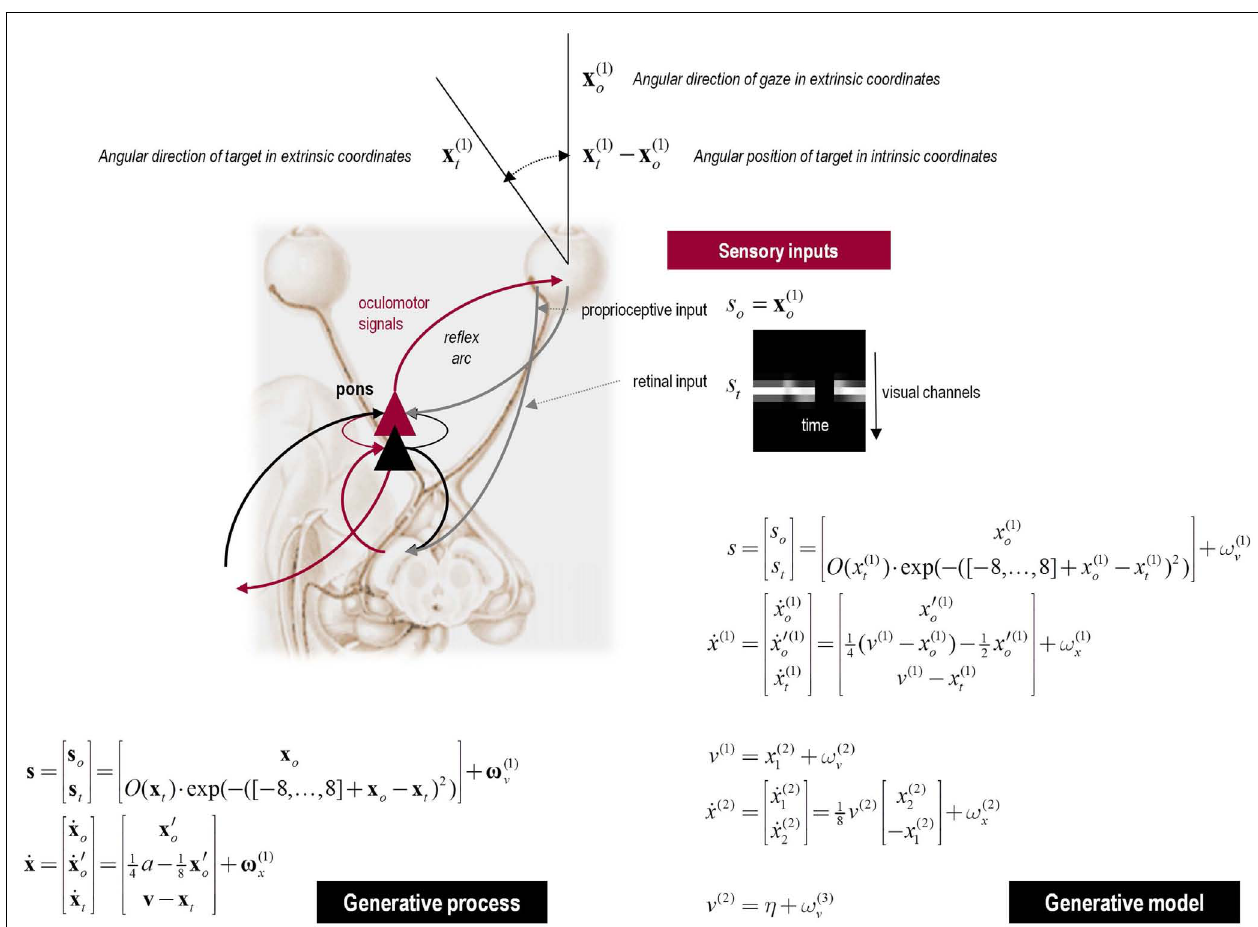
FIGURE 6 | Upper panel : this schematic summarizes the generative model for smooth pursuit eye movements .The model is based upon the prior belief that the center of gaze and target are attracted to a common (fictive) attracting point in visual space.The process generating sensory inputs is much simpler and is summarized by the equations specifying the generative process (lower left).The real-world provides sensory input in two modalities: proprioceptive input from cranial nerve nuclei reports the (horizontal) angular displacement of the eye s o and corresponds to the center of gaze in extrinsic coordinates x o . Exteroceptive (retinal) input reports the angular position of a target in a retinal (intrinsic) frame of reference s t .This input models the response of 17 visual channels, each equipped with a Gaussian receptive field deployed at intervals of one angular unit – about 2° of visual angle.This input can be occluded by a function of target location O ( x t ), which returns values between zero and one, such that whenever the target location x t is behind the occluder retinal input is zero.The response of each visual channel depends upon the distance of the target from the center of gaze.This is just the difference between the oculomotor angle and target location.The hidden states of this model comprise the oculomotor states – oculomotor angle and velocity (cid:0) x (cid:1) and the target location. Oculomotor velocity is driven by action and o , x (cid:48) o